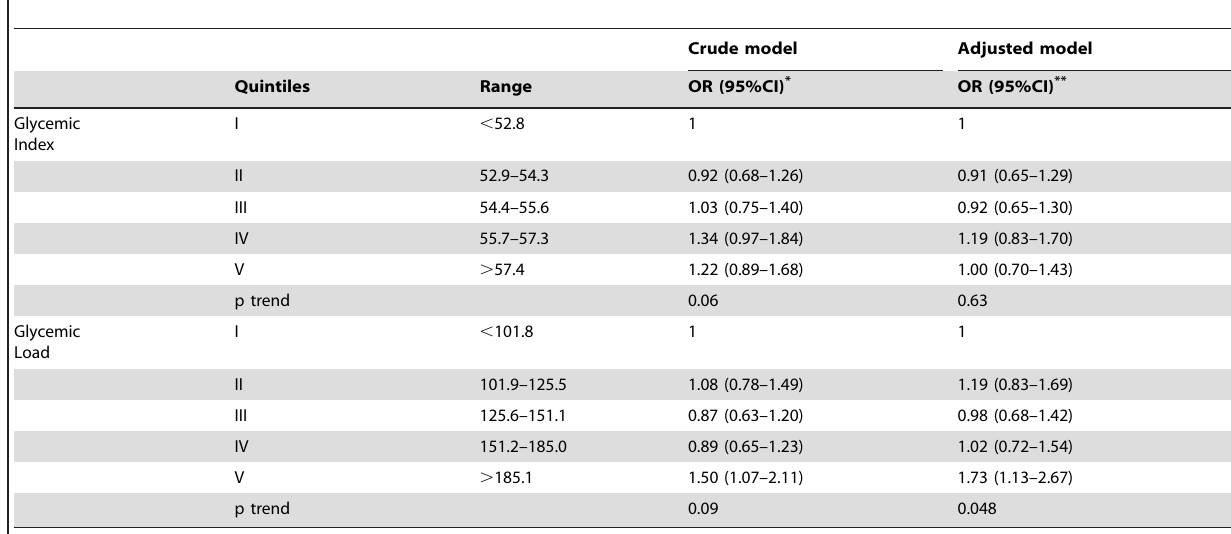
Table 3. Association between energy-adjusted GI, GL and high MBD (1,628 EPIC-Florence